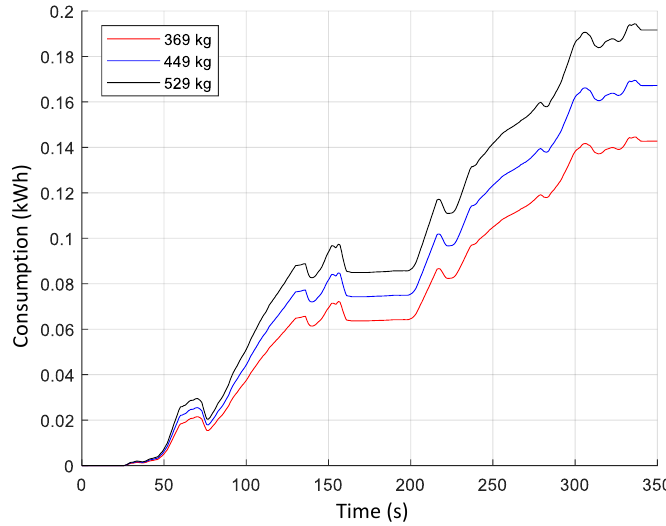
Figure 18. Effect of crew weight on Biro